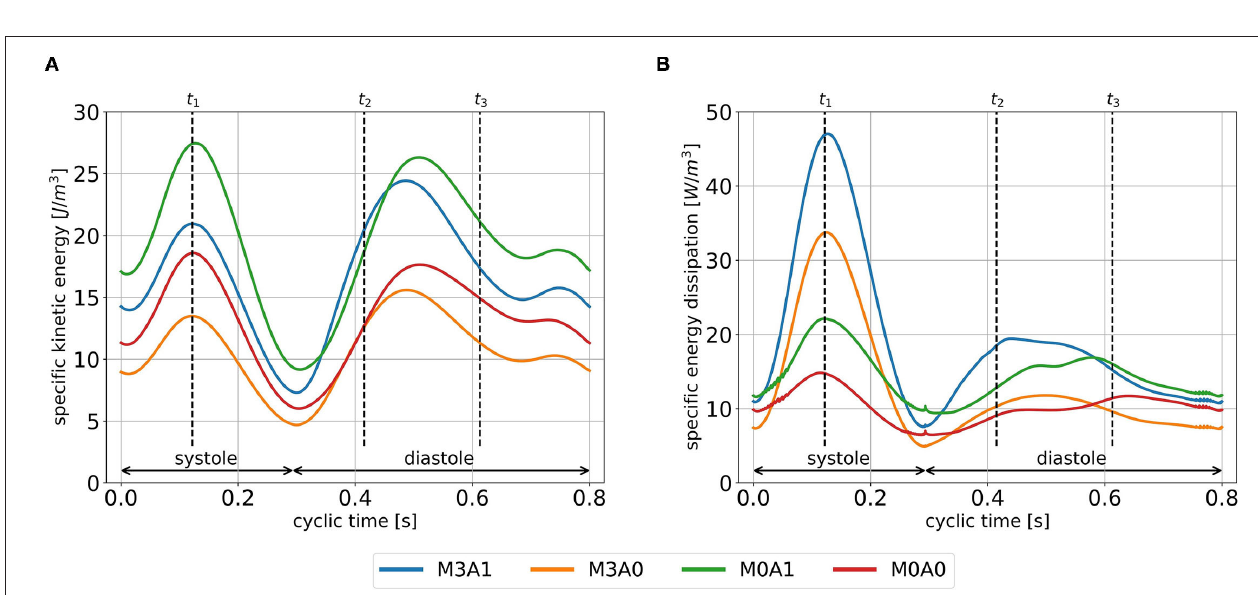
FIGURE 8 | Specific kinetic energy course (A) , and specific energy dissipation (B) averaged over cycles one to eight for all cases. Time points t 1 , t 2 , and t 3 mark peak systole, peak E-wave, and diastasis, respectively.